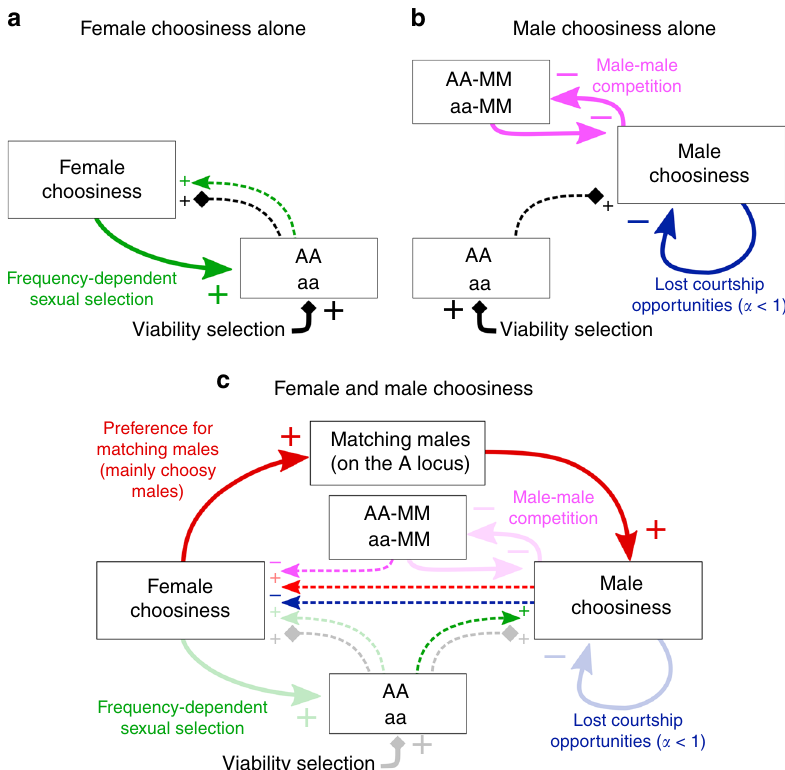
Fig. 1 Selective forces acting on female and male choosiness. Choosiness can only evolve in one sex ( a , b ) or can evolve in both sexes ( c ). Diamond arrows and classic arrows represent viability and sexual selection, respectively. Viability selection acts through differential survival (i.e., change in frequencies during the disruptive viability selection process), whereas sexual selection acts through differential male mating success (detailed in Supplementary Fig. 1). Bold and dashed arrows represent direct and indirect selection, respectively. AA and aa refer to homozygotes at the ecological locus and MM to choosy males. Selective forces represented with a low opacity in panel c are the ones already shown in panels a and